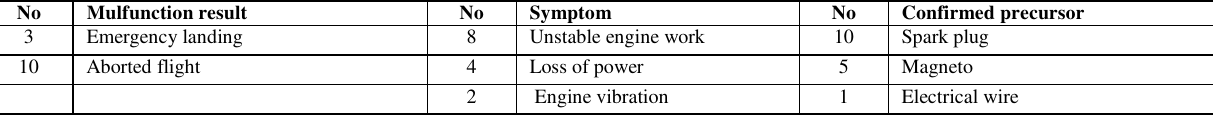
Table 7. Confirmed roots of the piston engines failures coded in the ATA 74 chapter which caused aviation event